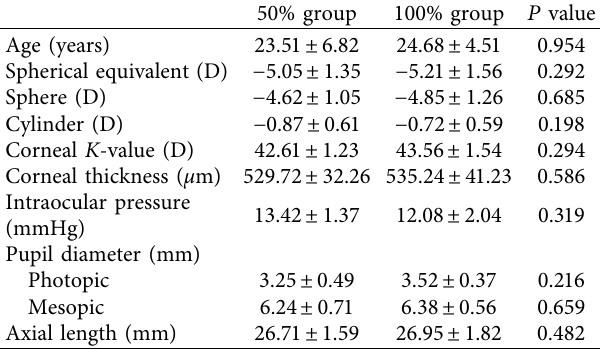
Table 1: Patient demographics and